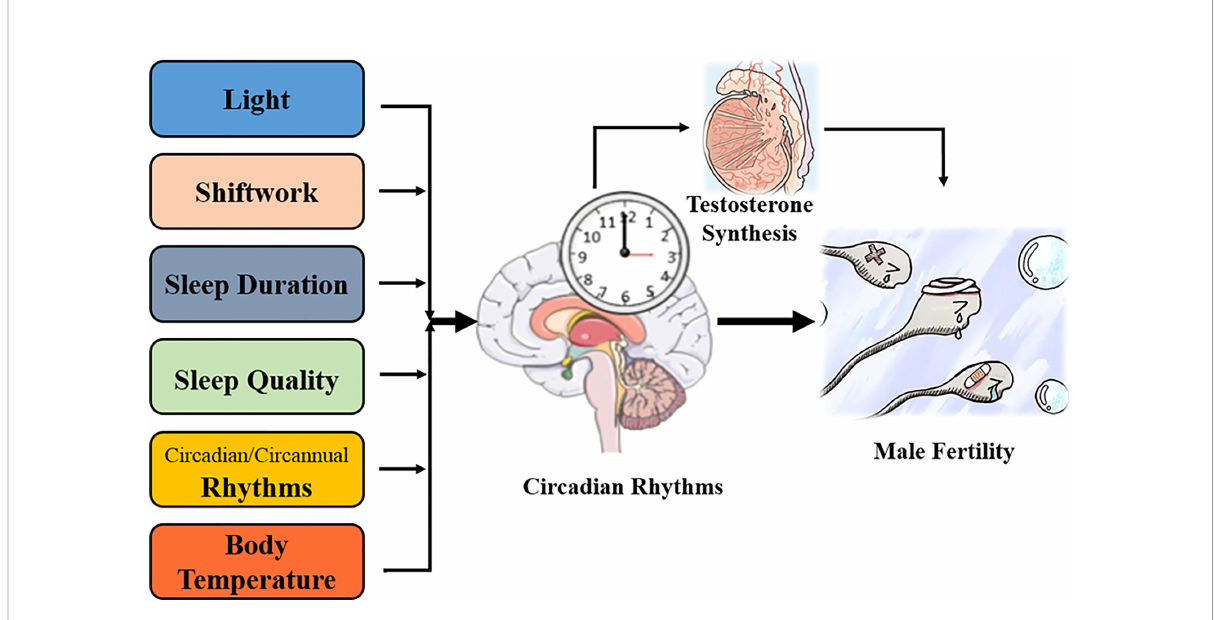
FIGURE 2 Involvement of circadian rhythms with male